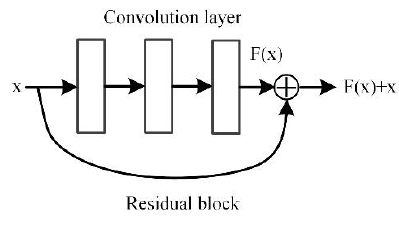
Figure 1. Residual unit.